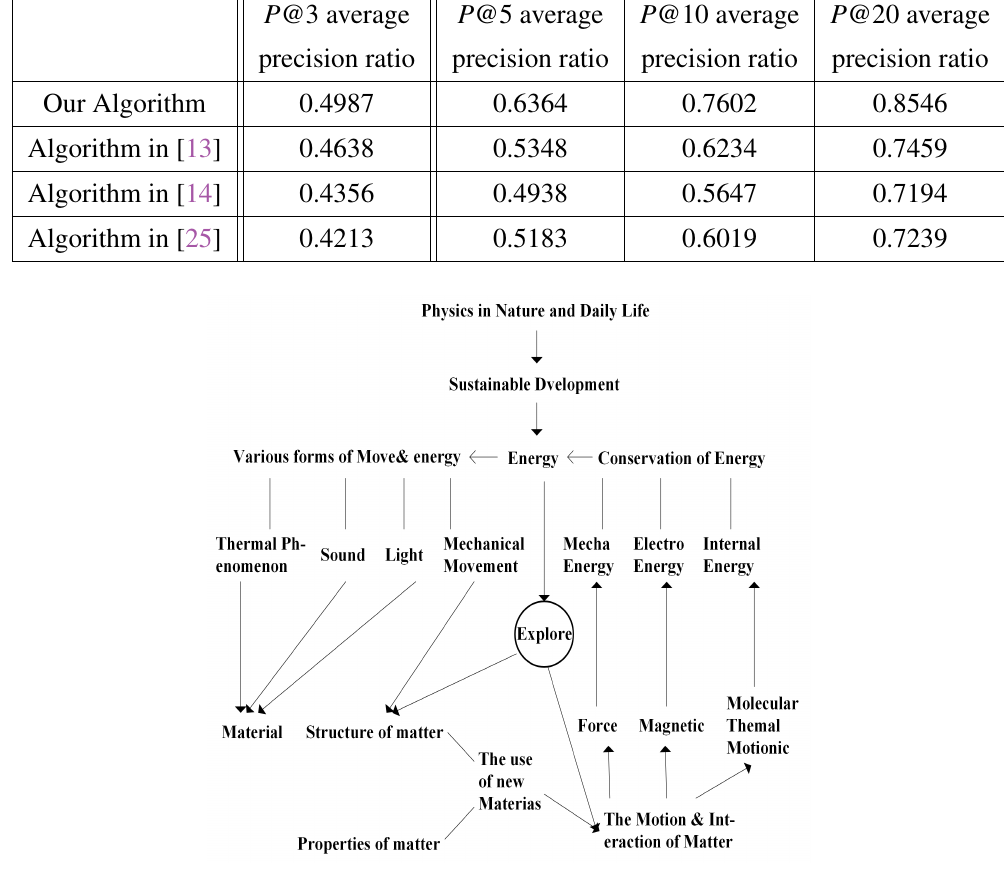
Table 3 Tab. 3. The Experiment Results of Ontology Similarity measure